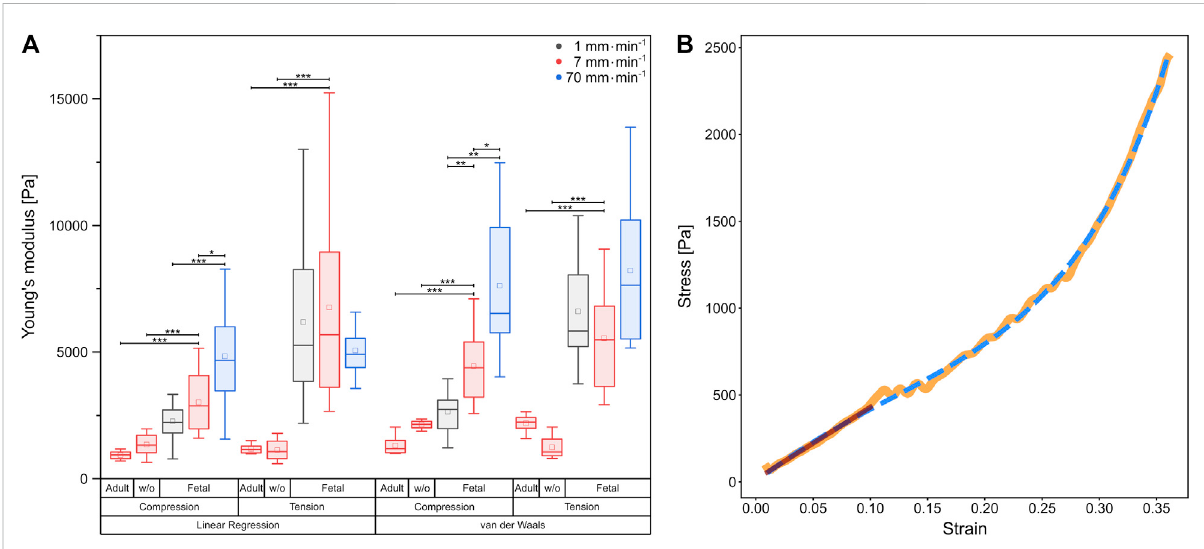
FIGURE 3 (A) Boxplot of Young ’ s moduli determined by linear regression, as well as calculation of the van der Waals model, respectively. Underlying data were obtained from compression and tension tests of fetal and rinsed (w/o) and unrinsed adult rat lung samples with different velocities represented by colors. Circlesshowmeanvalues,whilecentrallinesrepresentmedians(50thpercentile);thebottomandthetopofthebox(hinges)represent1stand3rdquartiles; theendofthewhiskersrepresenttheminimumandmaximumofthedata(hinges±1.5interquartilerange). (B) Comparisonoflinearregression(red)with the van der Waals model (blue dashed) on experimental data (orange) from a compression test at 7 mm · min − 1 using a fetal rat